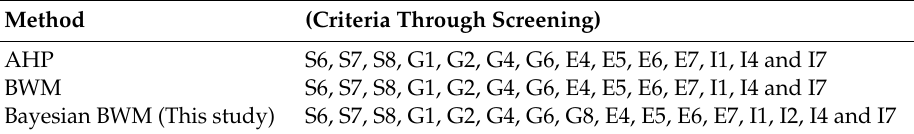
Table 5. Criterion screening results for three di ff erent